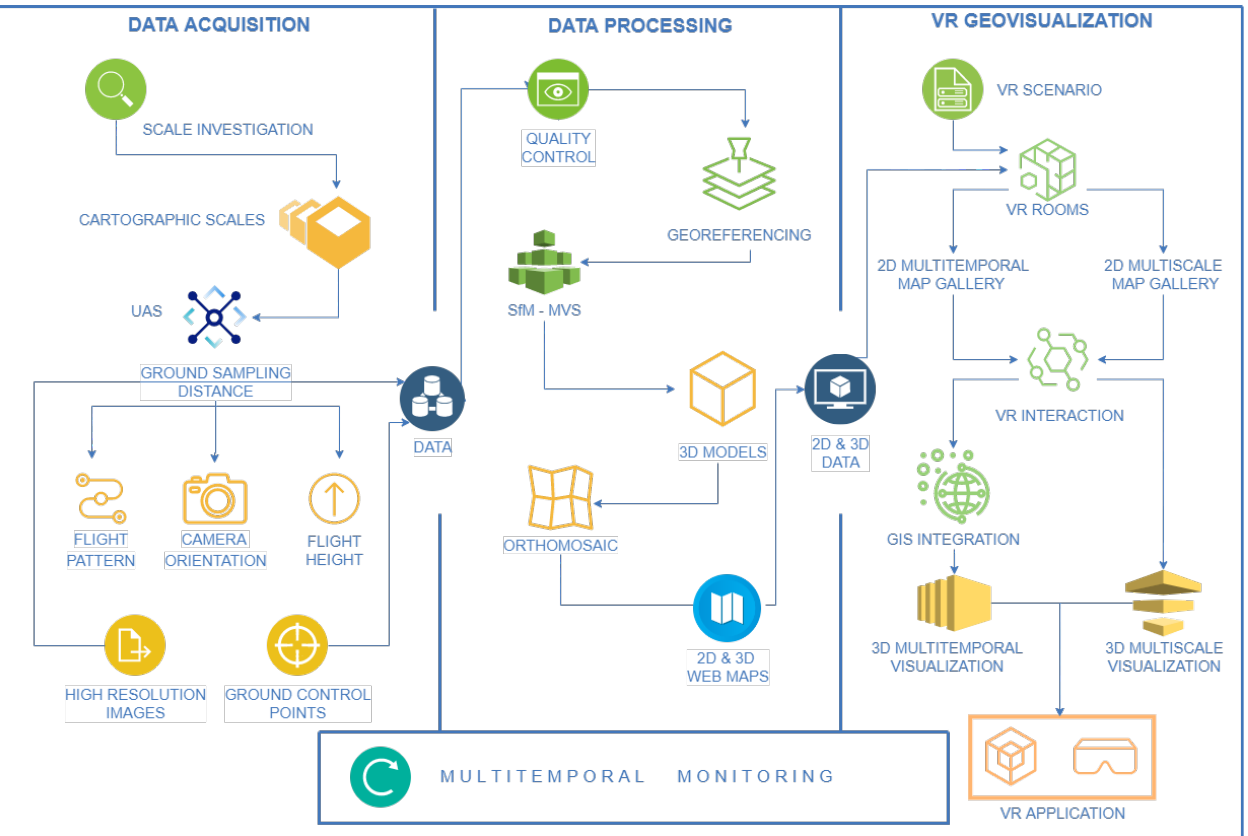
Figure 2. Flowchart of the main stages in the methodology.